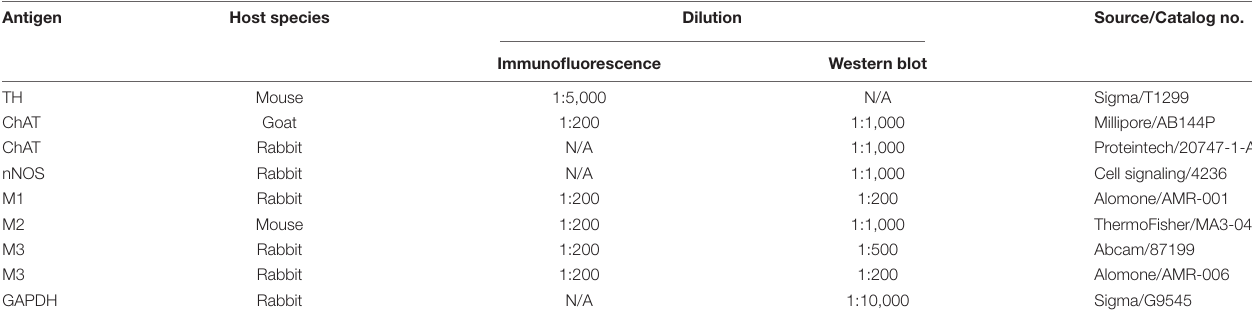
TABLE 1 | Primary